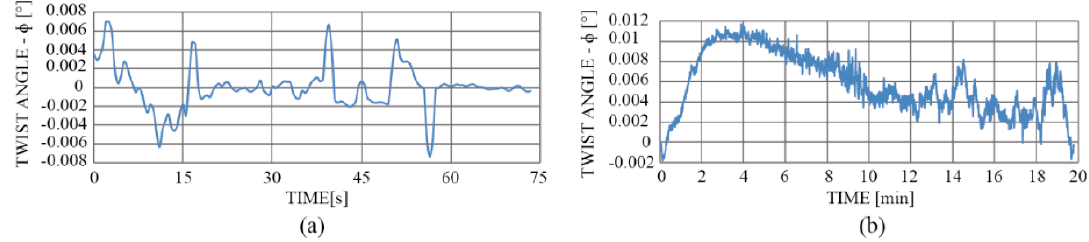
Figure 5. Influence of the change in ( a ) Length and ( b ) Temperature on the angle